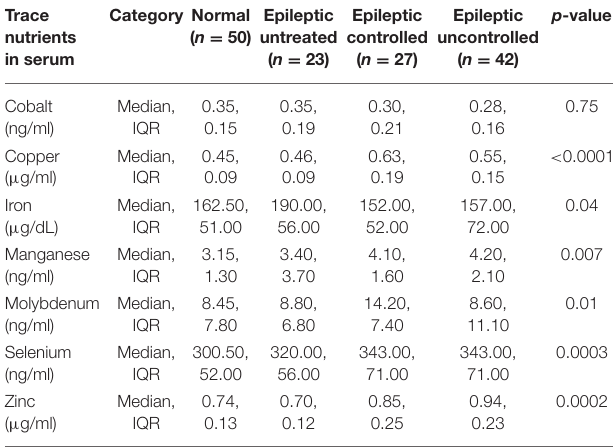
TABLE 3 | Trace nutrient concentrations in normal dogs ( n = 50) compared to the individual subgroups of epileptic dogs. Trace nutrients in